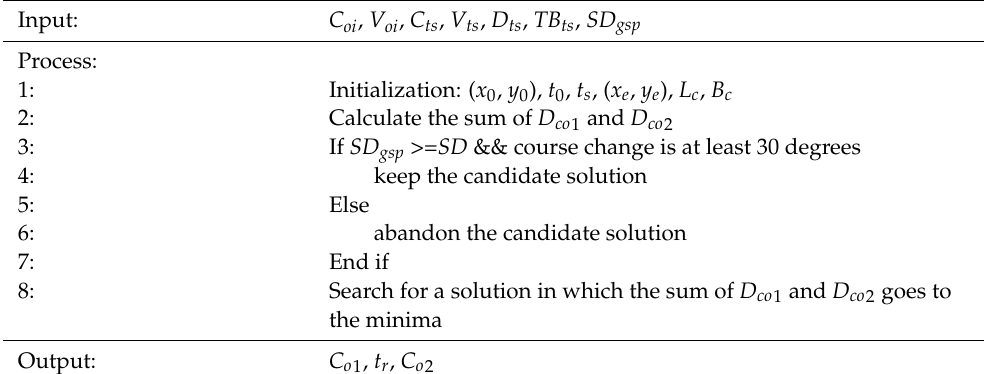
Algorithm 1: Pseudocode for collision avoidance path planning on the basis of DOA.